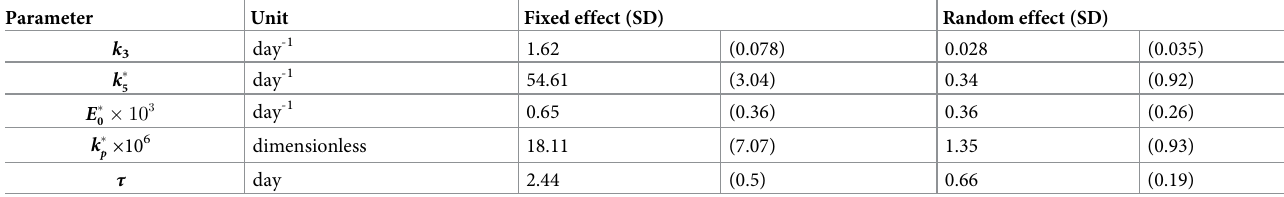
Table 4. Population parameters estimated by fitting the model to NP swab viral load data from mildly infected patients [38] (Fig 5A). Parameter Unit Fixed effect